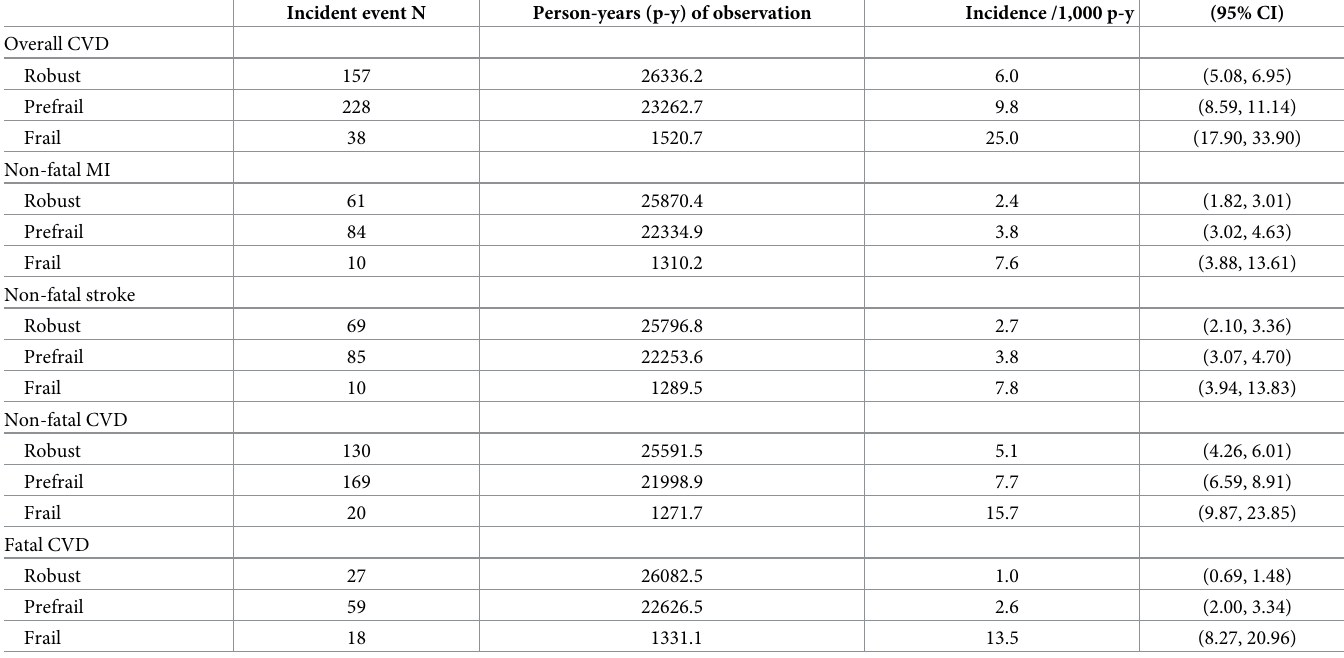
Table 2. Follow-up incidence rate of CVD events by baseline frailty status. Incident event N Person-years (p-y) of